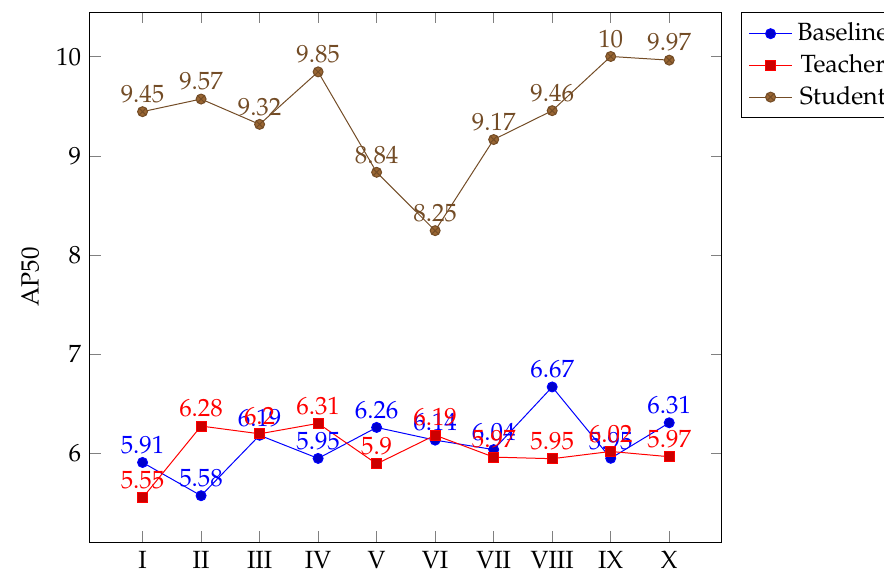
Figure 11. 10 last model weight comparison on VinTest dataset.